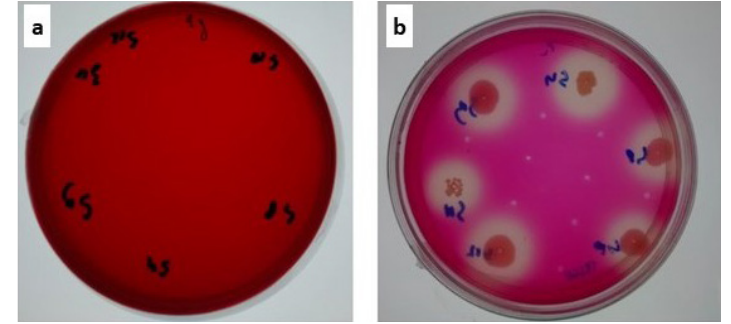
Figure 1 - Culture medium containing phenolphtaleine ( a ) as indicator of starch degradation by CGTase-producer bacteria. The clear halo around bacteria colony ( b ) is a result of the cyclodextrin-phenolphtaleine